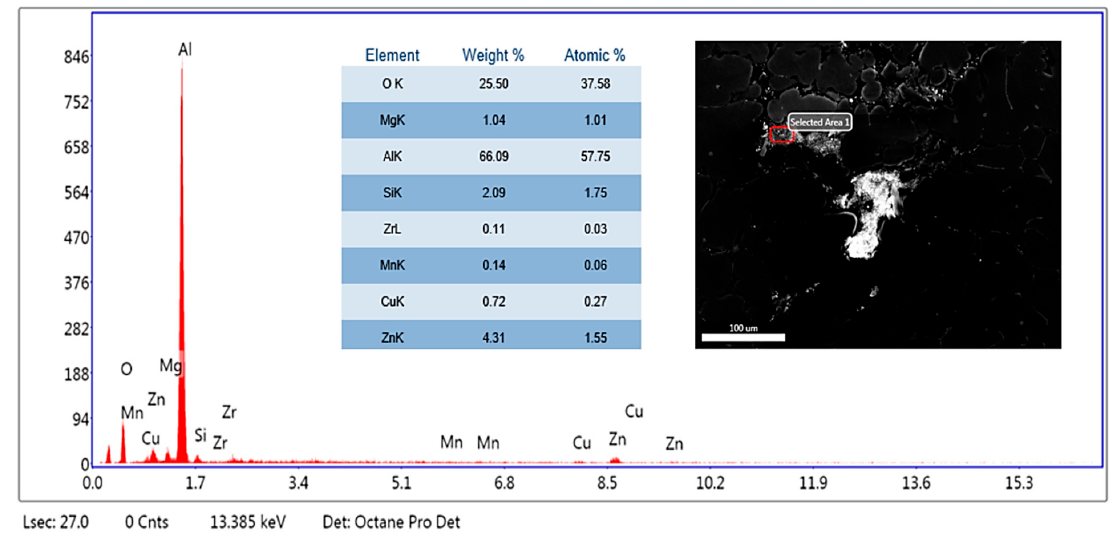
Figure 8. EDS of AA 5083/5 wt.% SiC/6 wt.% fly ash.